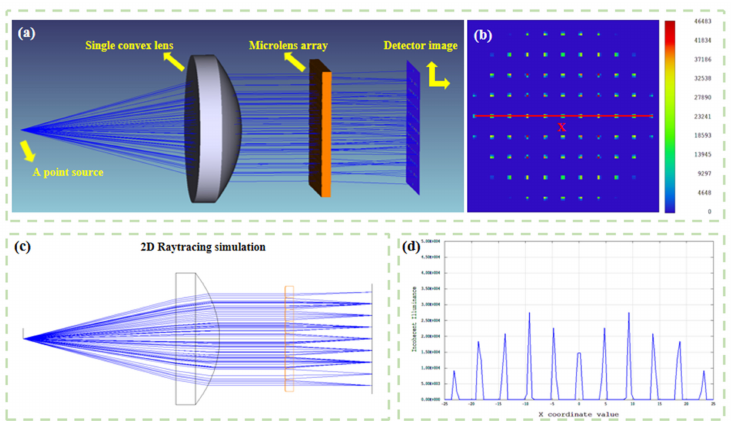
Figure 7. Simulation of optical imaging. ( a ) Three-dimensional schematic diagram of optical sim- ulation, ( b ) simulated light focusing points on the receiver, ( c ) planar ray tracing simulation, and ( d ) light intensity distribution of the receiver x section.